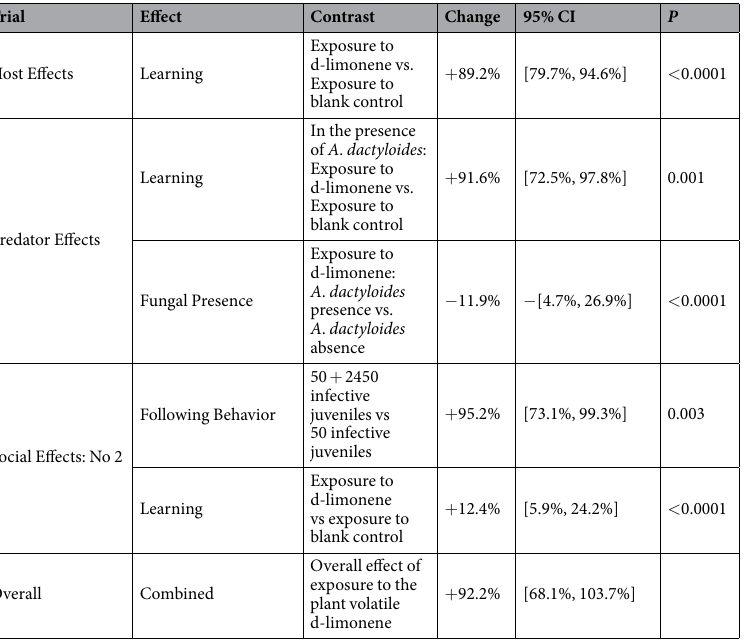
Table 1. Multitrophic effects of behavioral plasticity in entomopathogenic nematodes. Change reflects percent change in host infection probability. Overall effects are estimated by averaging effects from Host, Predator, and Social Effects